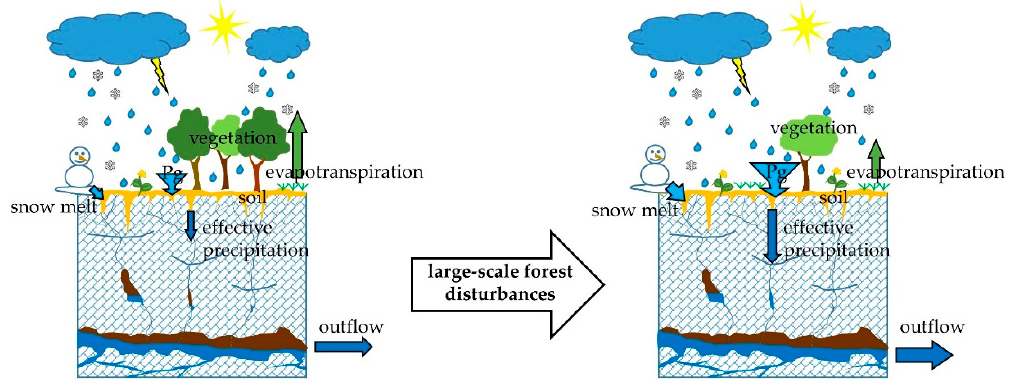
Figure 6. Conceptual model of the impacts to the effective precipitation and spring discharge changes due to large-scale forest disturbances. The change of an arrow size illustrates the relative change of the respective parameter.